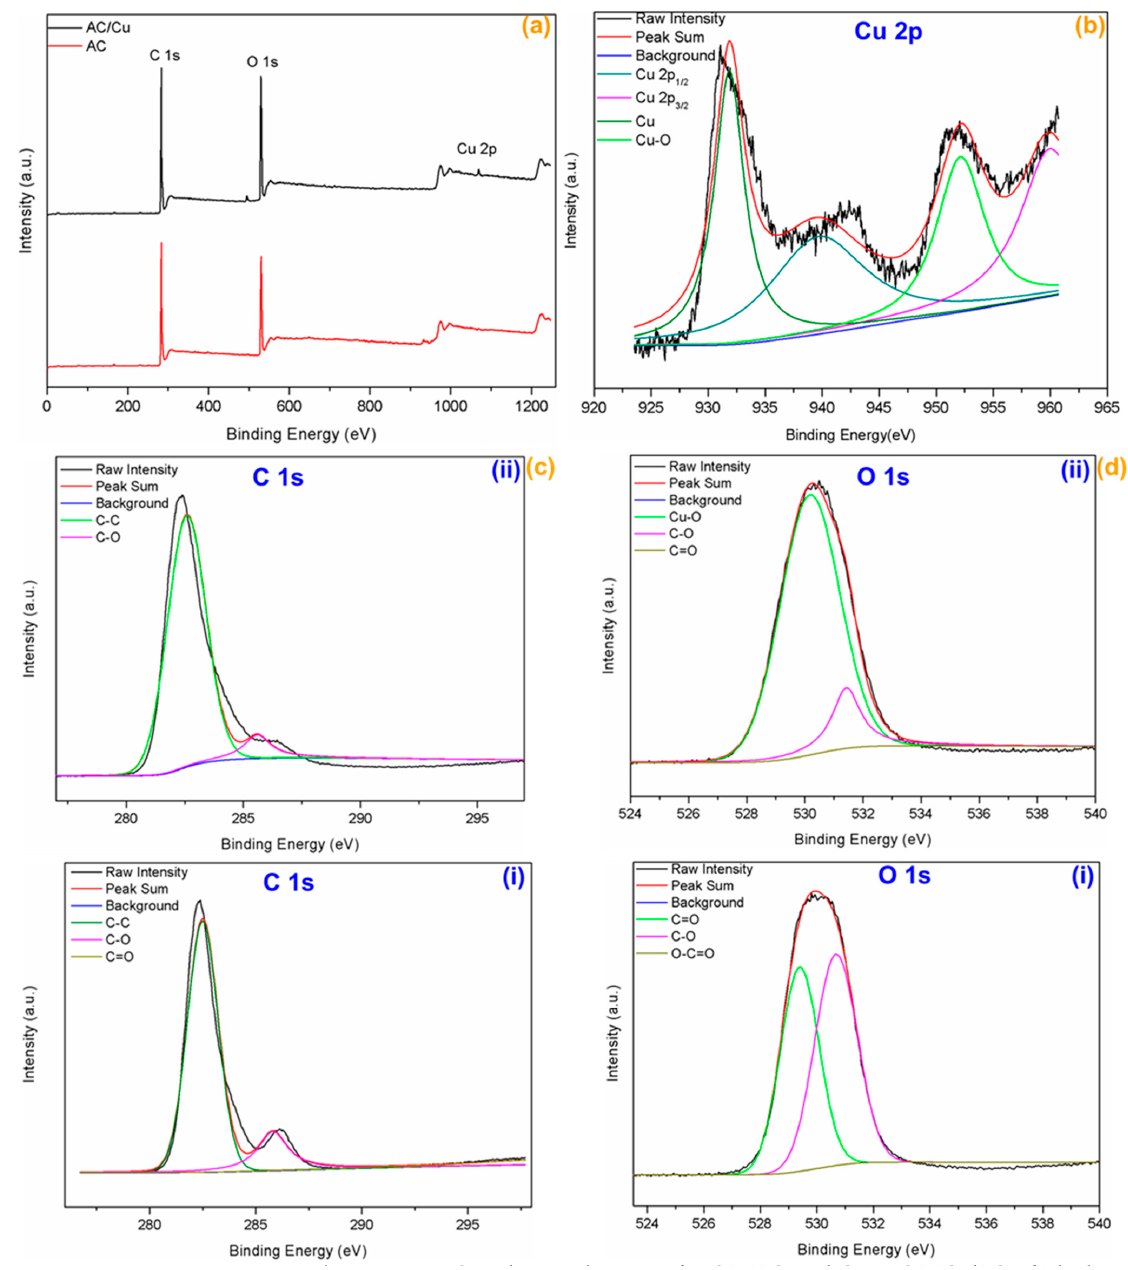
Figure 5. ( a ) XPS total spectral survey of TFSA (AC) and Cu@TFSA (Cu/AC); ( b ) high-resolution spectra of Cu 2p ( c ) C 1s, and ( d ) O 1s of ( i ) TFSA, and ( ii ) Cu@TFSA, respectively. Overall, the characterization suggests that the copper was successfully adsorbed onto the TFSA surface. The TEM images show that the copper nanoparticles were formed on the surface. The disappearing COOH group on the FTIR and the presence of the CuO peaks on the XPS, suggest that the nanoparticles were formed in situ. Although there is no clear distinction between Cu(I) and Cu(0), all the supporting evidence suggests that